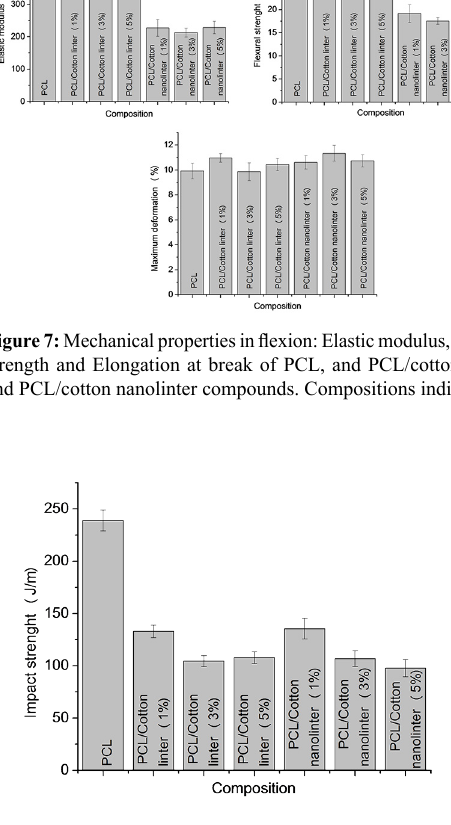
Figure 8: Impact strength of PCL, and PCL/cotton linter and PCL/ cotton nanolinter compounds. Compositions indicated.